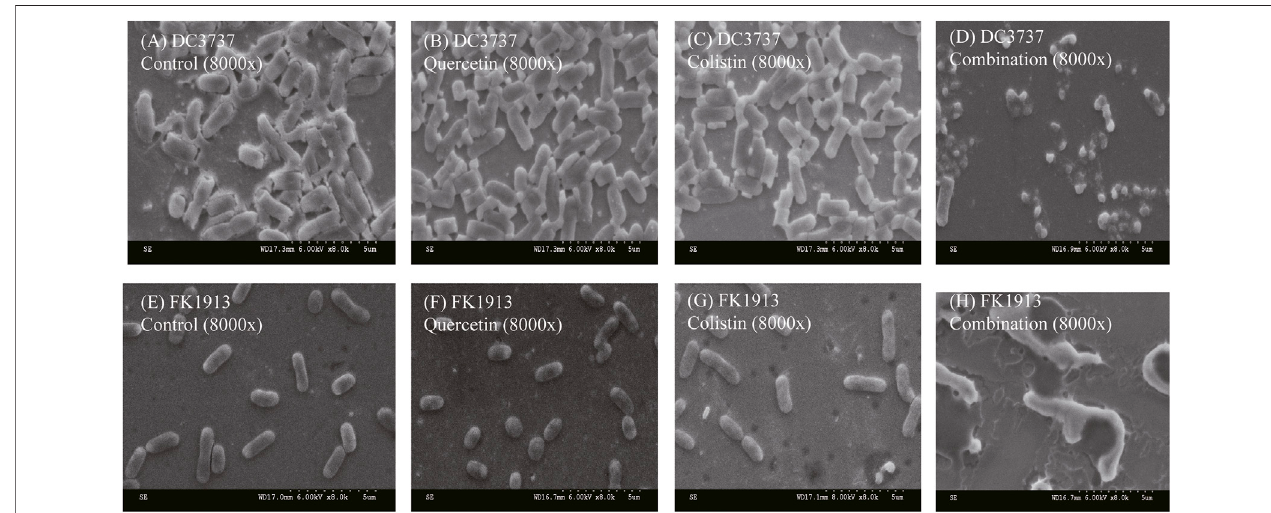
FIGURE 5 | SEM images showing the morphological change of bacterial cell membrane of E. coli DC3737 and K. pneumoniae FK1913 after various treatments.